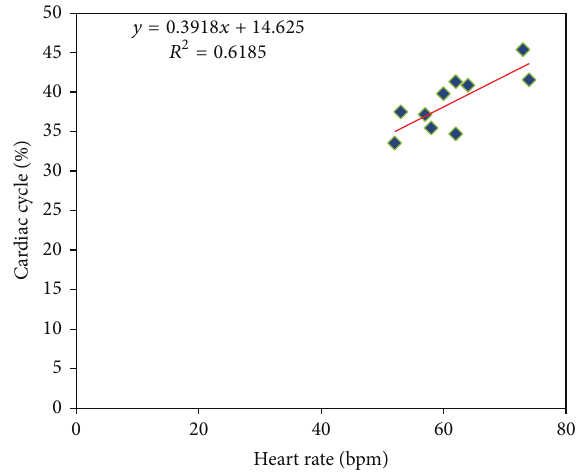
Figure 10: The regression of cardiac cycle percentage and heart rate for 10 healthy subjects as well as best linear fit trend lines.